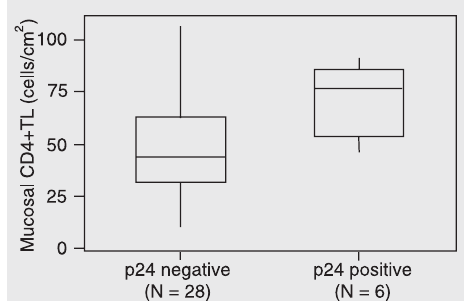
N = number of individuals. χ 2 : P = 0.05.